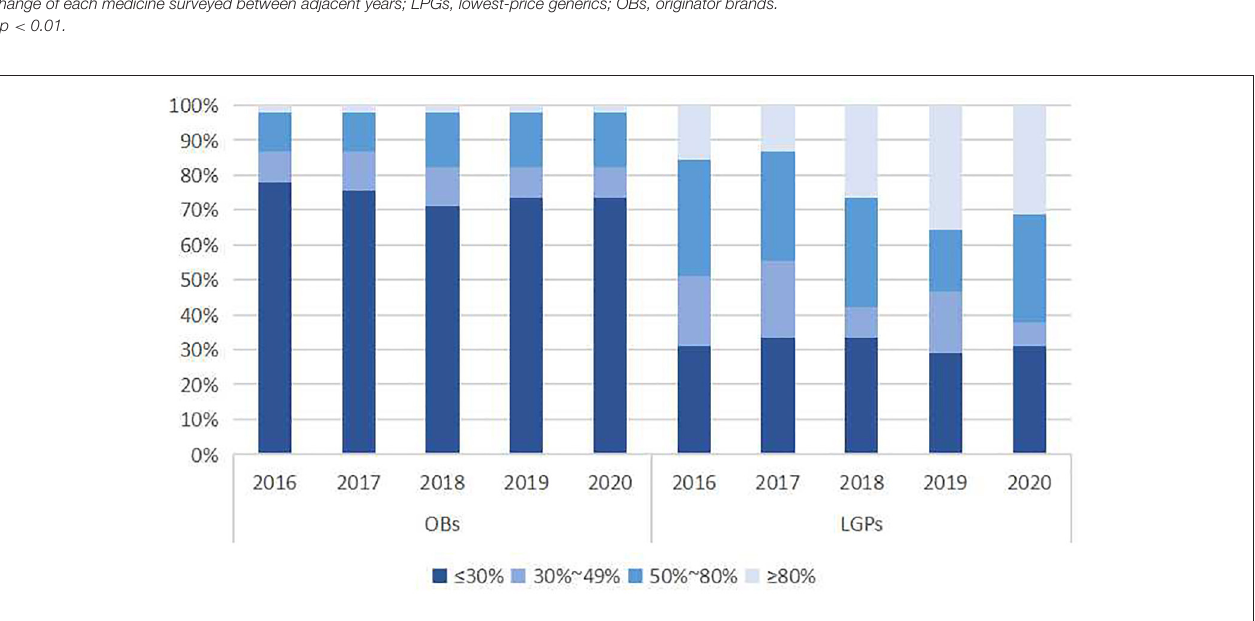
FIGURE 1 | Availability of 45 essential medicines in Nanjing from 2016 to 2020